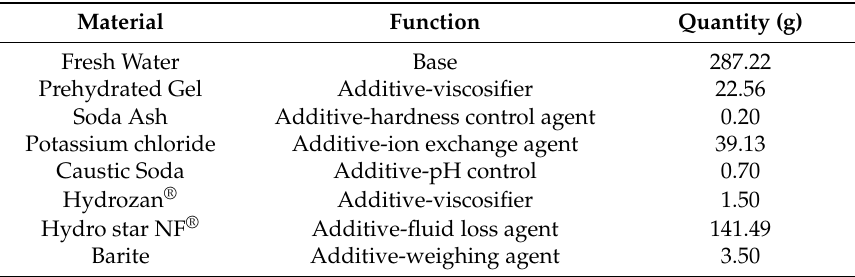
Table 2. Formulation of water-based